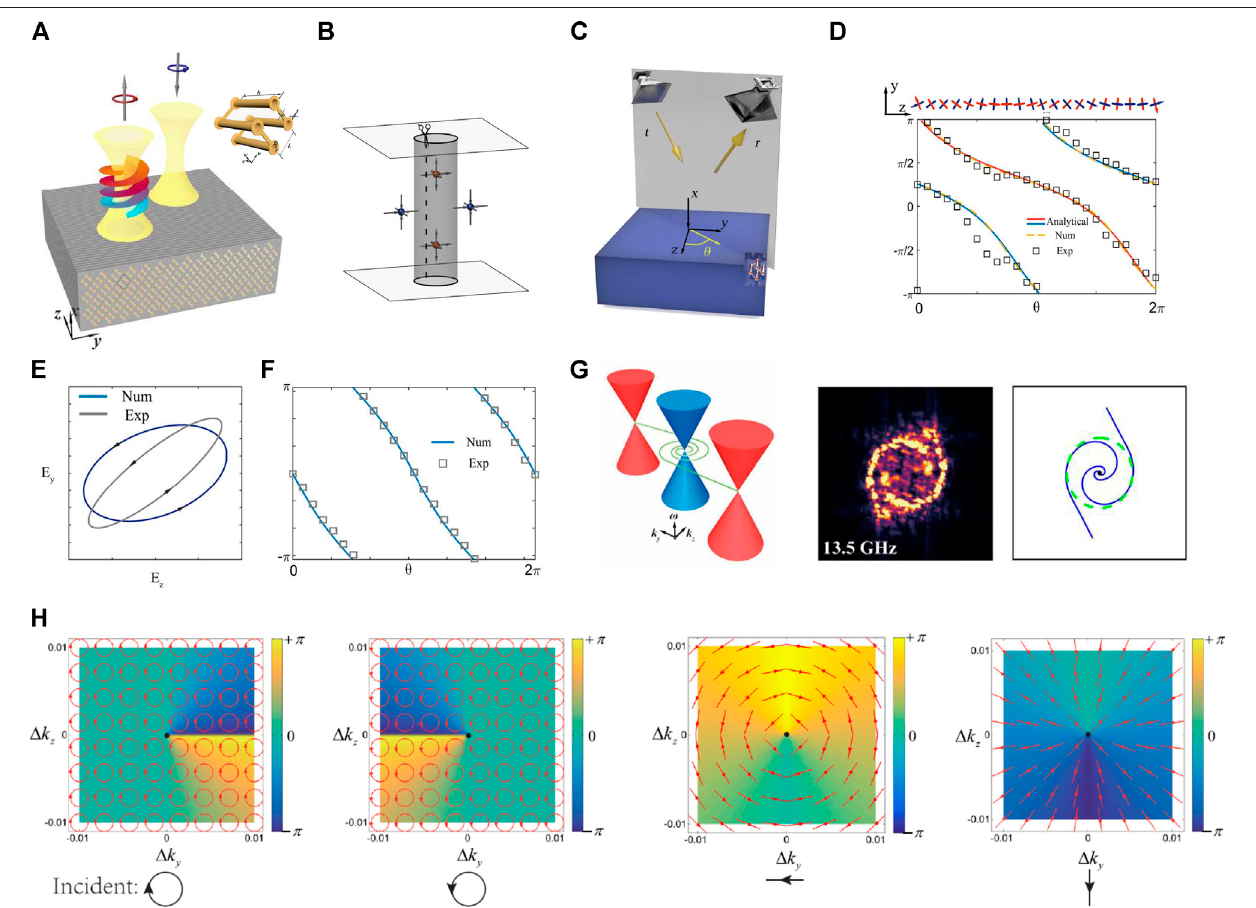
FIGURE6|(A) VorticalmirrorinWeylmetamaterialiscomposedofmetallicsaddle-shapedstructure,andanincidentGaussianbeamcanbere fl ectedintoavortex beam [84]. (B) Weyl nodes with arrows indicating the directions of the Berry curvatures. Cylindrical surface enclosing the Weyl points has a topological charge of 2. (C) Re fl ection measurement setup in a microwave. (D) Re fl ection phases of the eigenstates and the eigenpolarizations of the Jones matrix for incident light. (E) An incident beam with the right-handed elliptical polarization state gives rise to (F) 4 π phase winding, generating a vortex beam. (G) Spiral Fermi arcs formed by re fl ection between the Weyl metamaterial and perfect electric conductor. (H) Re fl ection spectrum around a 3D Dirac metamaterial [81].